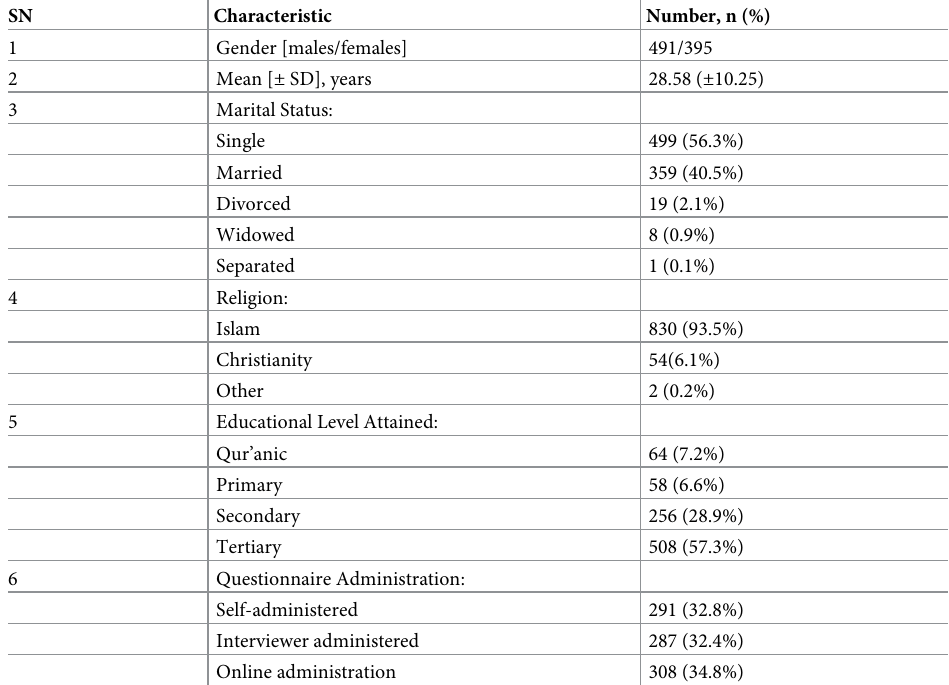
Table 1. Baseline demographic characteristics of survey participants (n =